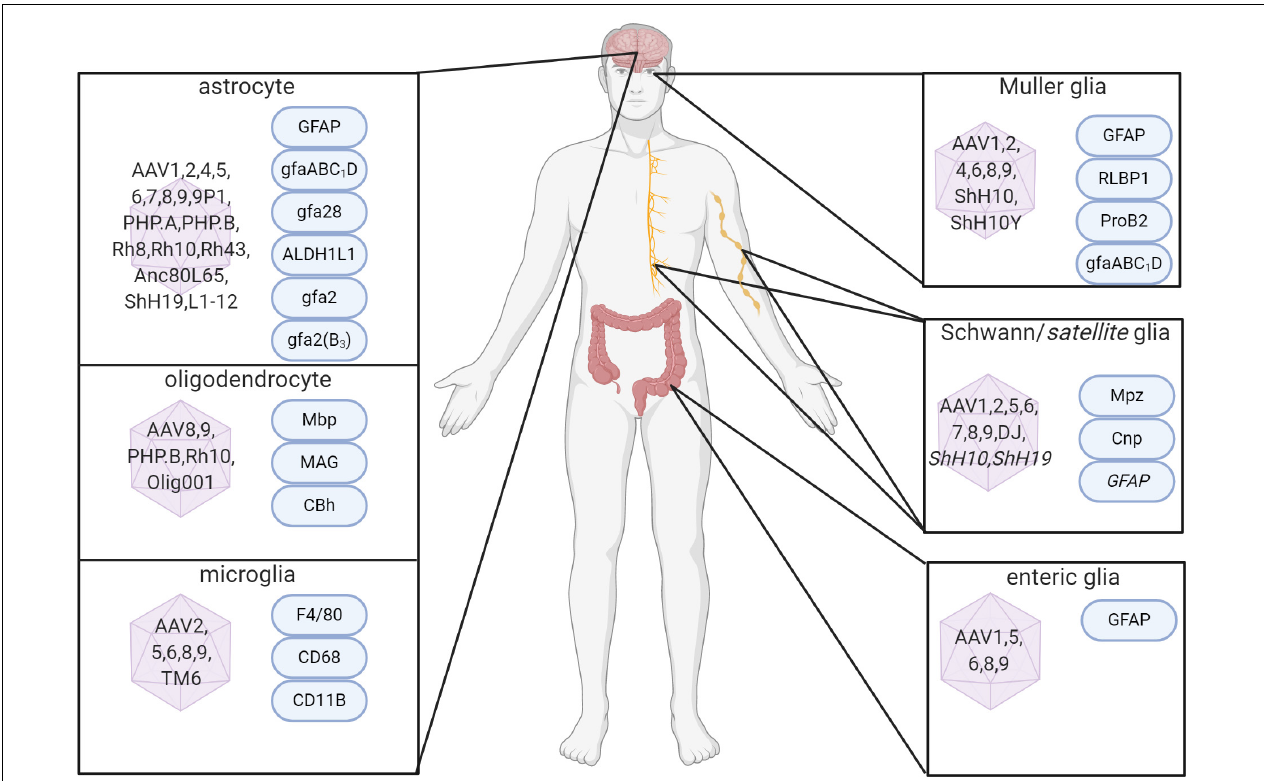
FIGURE 1 | Capsid serotypes and promoters for glial targeting of AAV. Overview depicting naturally-occurring and engineered AAV viral vectors with known glial cell tropism in the CNS and PNS and relevant cell-specific promoters. References used for this figure are detailed and cited in the text. Created with